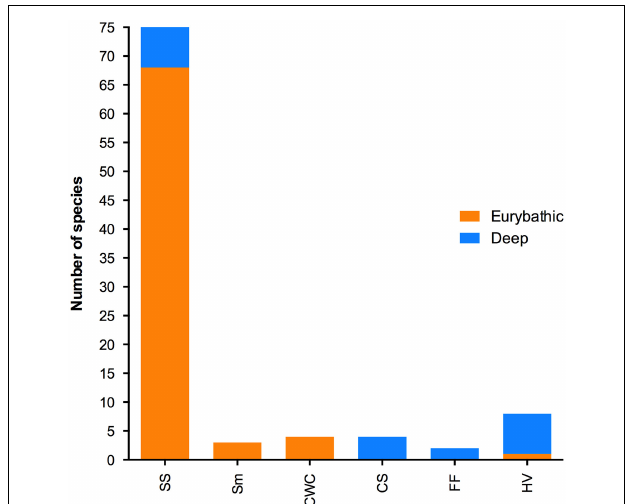
FIGURE 1 | Number of deep-sea and eurybathic species for which PLD has been estimated in different deep-sea habitats (SS, sedimentary slope; Sm, seamounts; CWC, cold water coral; CS, cold seeps; FF, food falls; HV, hydrothermal vents).